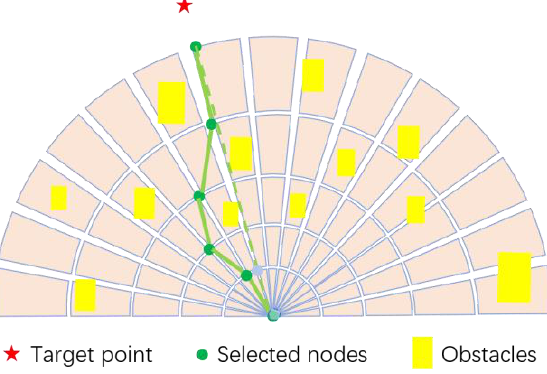
Figure 8. Node selection and connection.